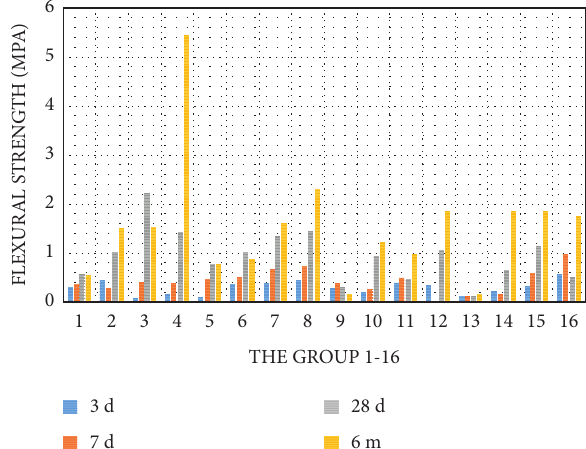
Figure 4: 3 d, 7d, 28d, and 6-month flexural strength.